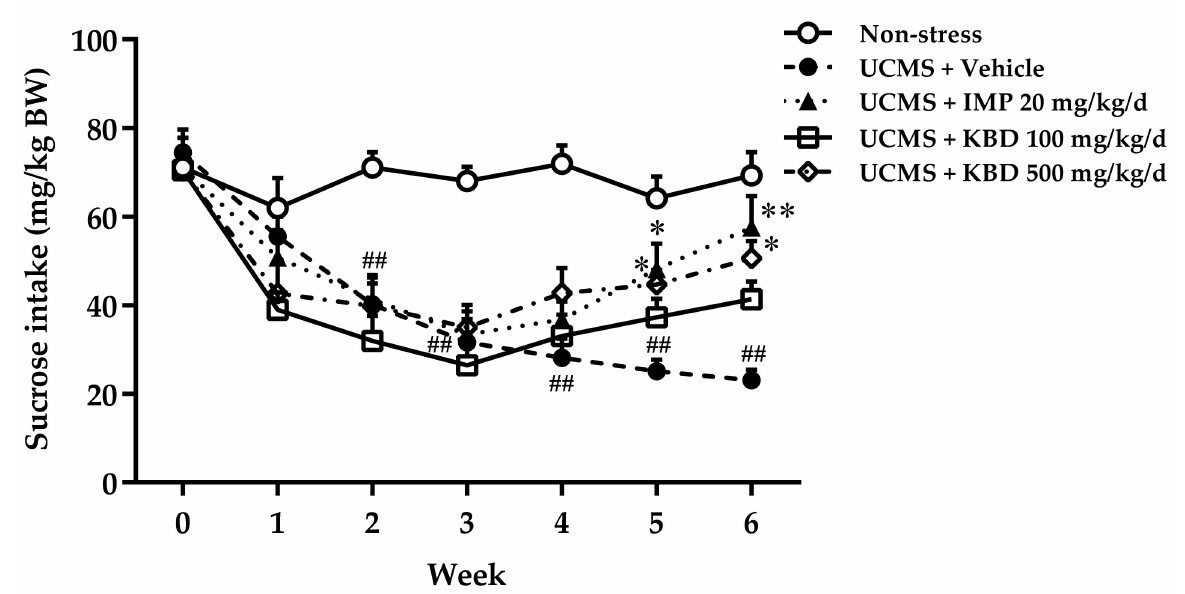
Figure 1. Effect of daily imipramine or KBD formula treatments on UCMS-induced anhedonia. Reductions in the amount of 2% sucrose solution taken indicate anhedonia. Each data point represents the mean ± S.E.M. ( n = 10 in each group). ## p < 0.001 vs. vehicle-treated non-stress group. * p < 0.05 and ** p < 0.001 vs. vehicle-treated UCMS